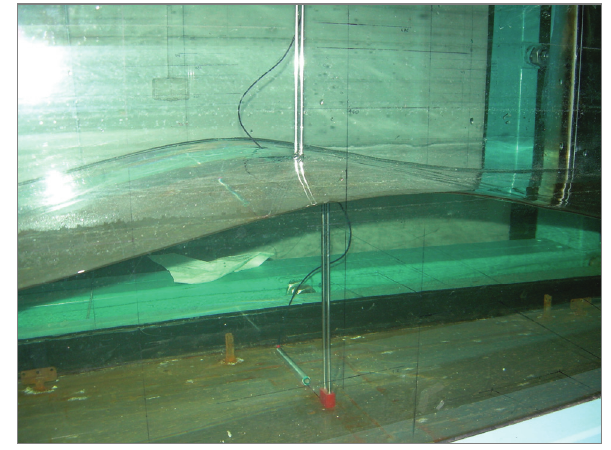
Fig. 3. Experimental set-up for measuring wave-induced pressures at the